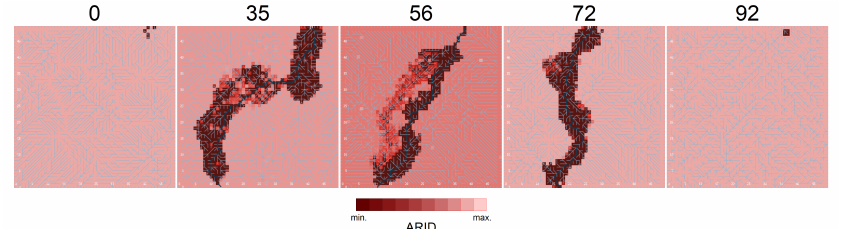
Figure 7. Example of ARID spatial distribution for each terrain obtained with the land crop model at simulation step 365 (end of first year), a no-rain day, under the default parameter setting, and randomSeed = 0. Color saturation gradient represents the interval between case-wise minimum and maximum ARID